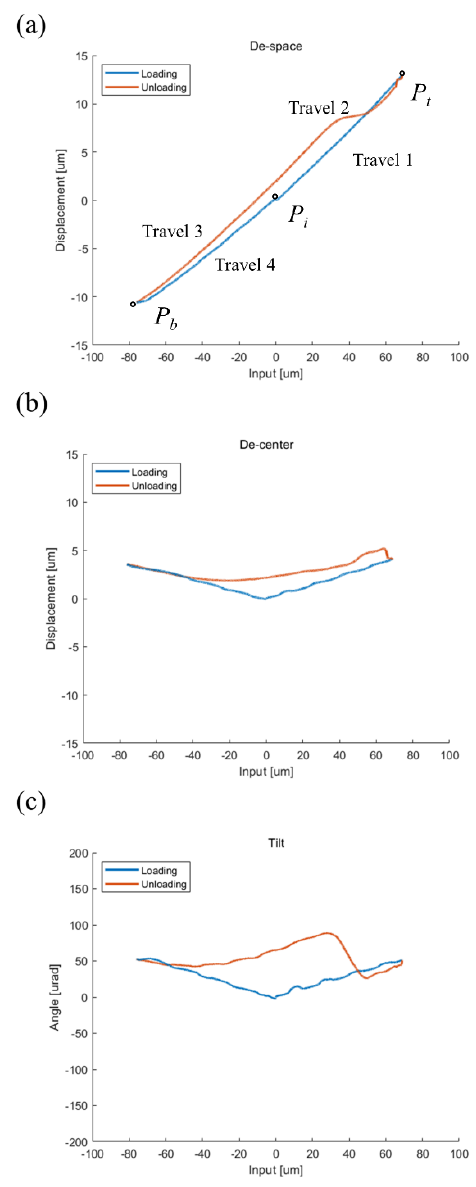
Figure 9. Experimental results for the input versus the optical alignments; ( a ) De-space, ( b ) De-center, and ( c ) Tilt.